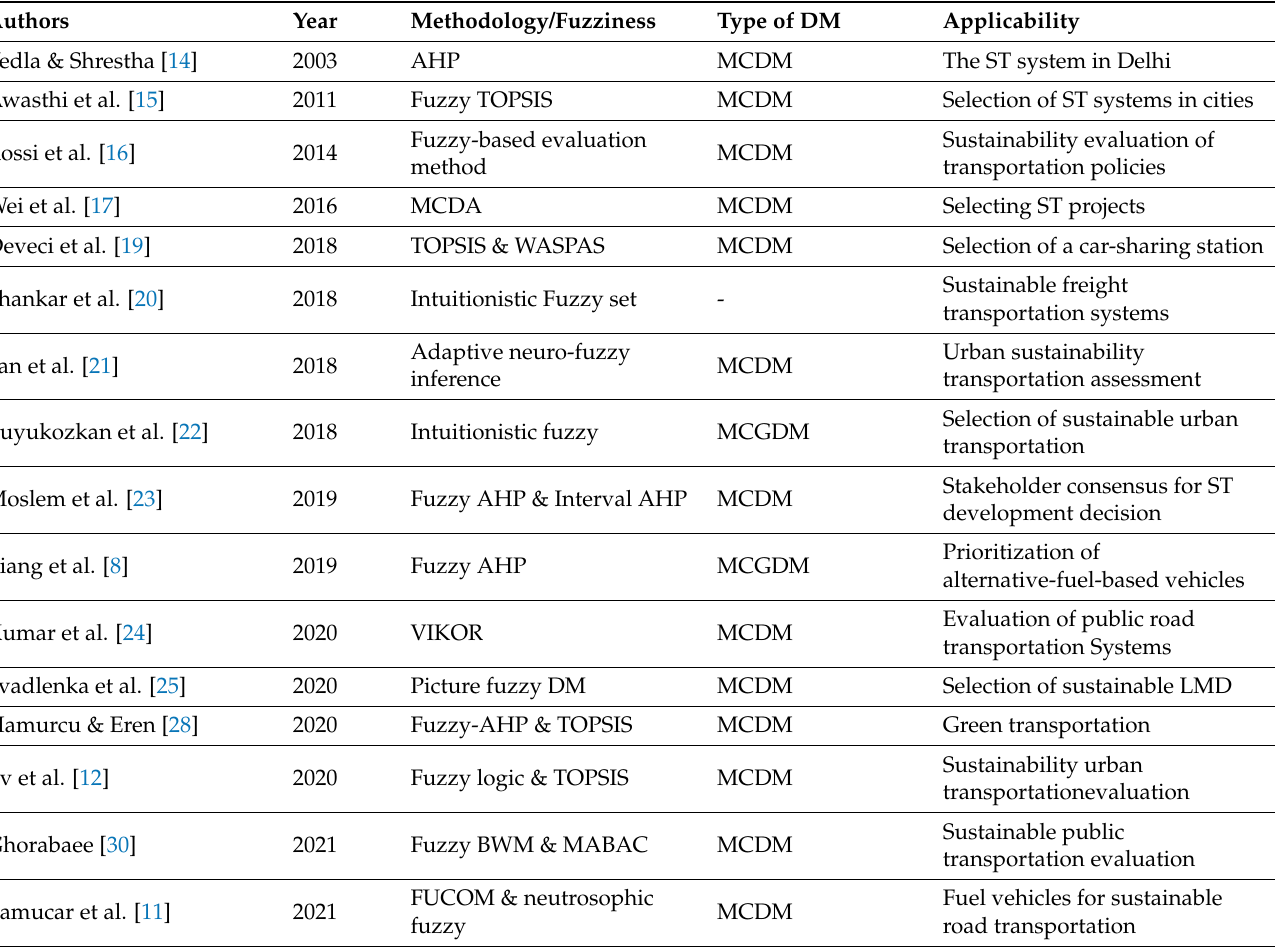
Figure 3. Sustainable transportation articles of a fuzzy nature for the period 2000–2022. Table 1. Literature survey on decision-making approaches to sustainable transport under a fuzzy environment.